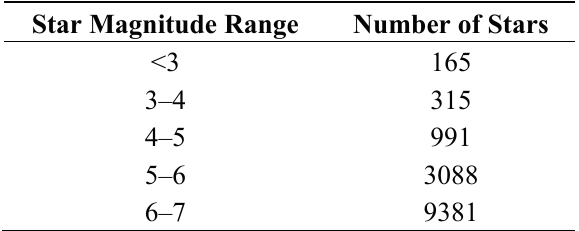
Table 2. Number of HC Stars for Each Star Magnitude.